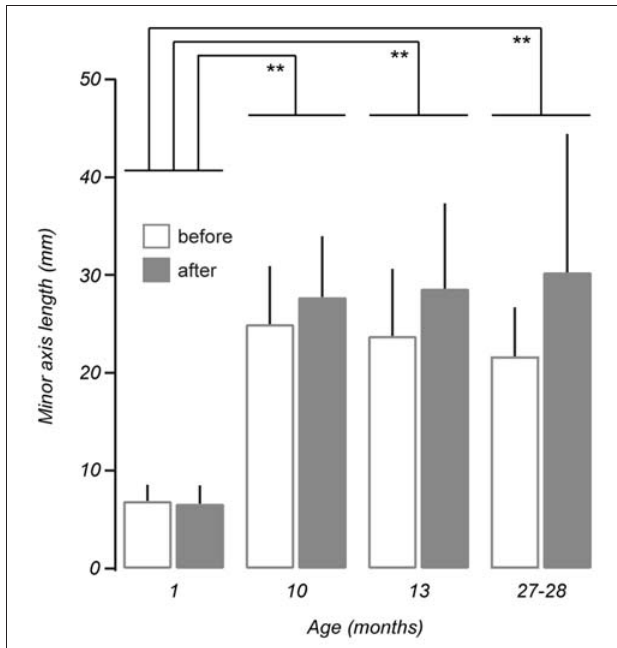
FIGURE 5 | Comparison of mean minor axis length before and after vestibular stimulation for all age groups tested . No linear interaction was found between the effect of the vestibular stimulus and ageing ( p > 0.05, repeated measures ANOVA). Post hoc comparisons showed non-linear, age-related differences in minor axis length between 1-month-old mice ( n = 3) and 10 ( n = 7, p < 0.01), 13 ( n = 6, p < 0.01), and 27–28-month-old mice ( n = 8, p < 0.01). Error bars = SD , ∗∗ p <